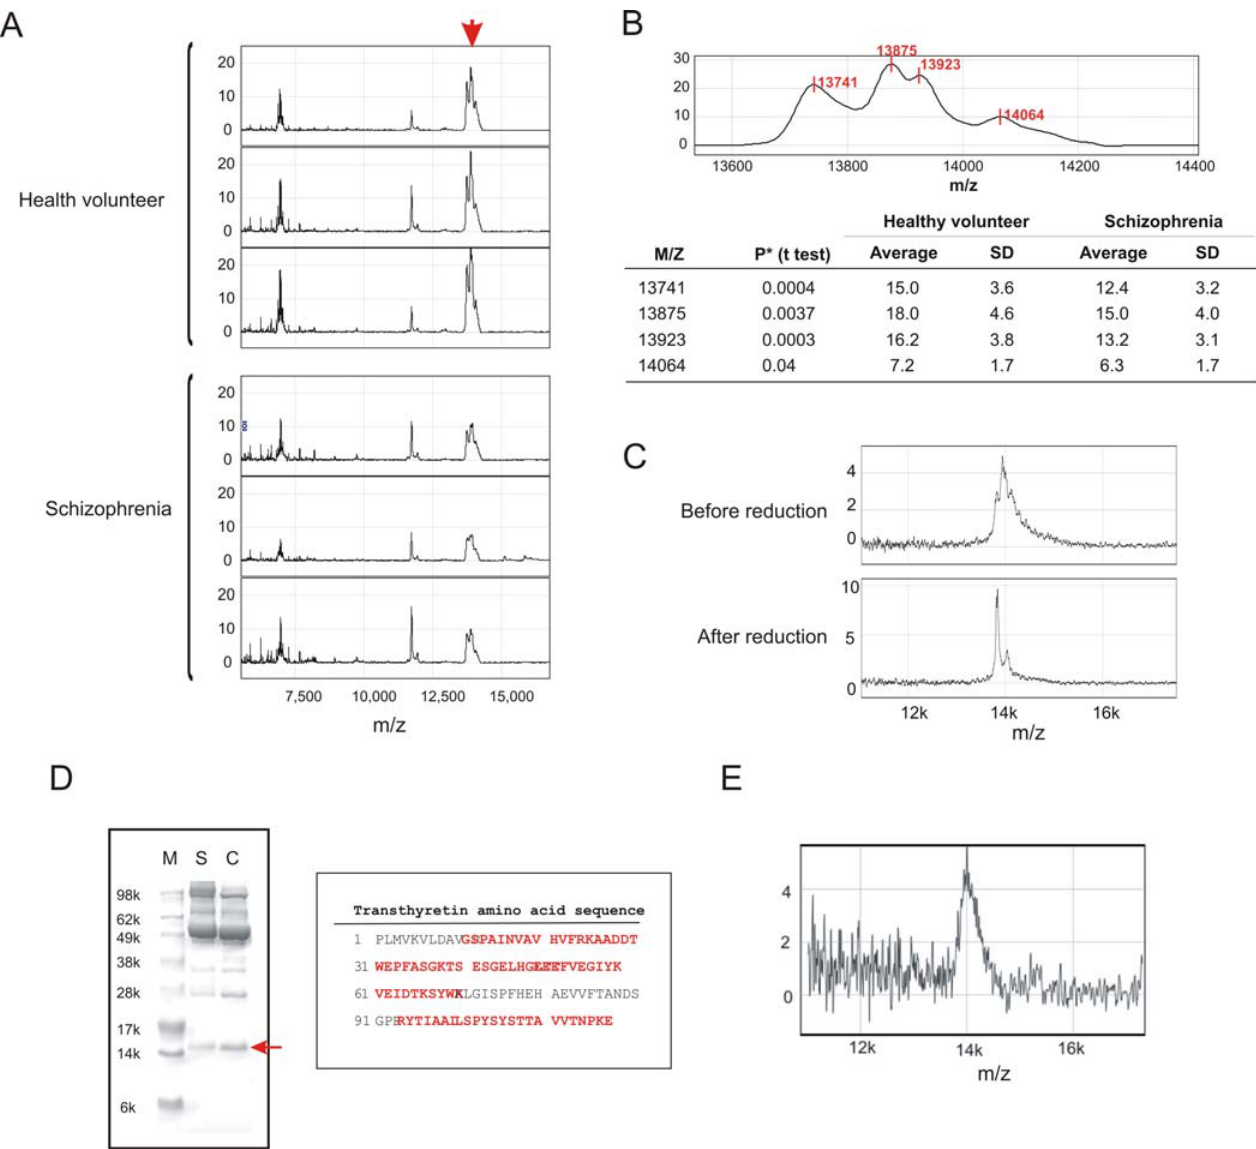
Figure 4. Down-Regulation of Three Different Forms of Transthyretin in CSF from First-Onset, Drug-Naı¨ve Schizophrenia Patients Examples of CSF spectra from healthy volunteers and patients with schizophrenia within 6–17 kDa are shown in (A). The peak cluster indicated (red cursor) is enlarged in (B). Statistical details of each sub-peak are listed in the table presented just below (B). On-chip reduction of CSF peptide/protein with b -mecaptoethanol at room temperature showed that the three peaks 13,741, 13,875, and 13,923 Da were reduced into a single peak (C), suggesting that they are different S -cysteinylated derivatives of the same protein. To identify the protein, CSF samples from a healthy volunteer and a patient with schizophrenia were applied to an anion exchanger column (HyperD, Ciphergen Biosystems) and eluted with pH 9–pH 3 buffers. A major ; 14–15-kDa band was eluted in the pH 3 fraction (D, left panel). The protein was identified as transthyretin using LC-MS/MS (D, right panel) and the sequence coverage is shown in red. Note, that all the peptides shown have an E- score of , 0.05, indicating a high probability for the assigned protein identity. In addition, the band was confirmed to be the peak cluster at around 13.5–14 kDa in the spectra by eluting the protein(s) from the gel